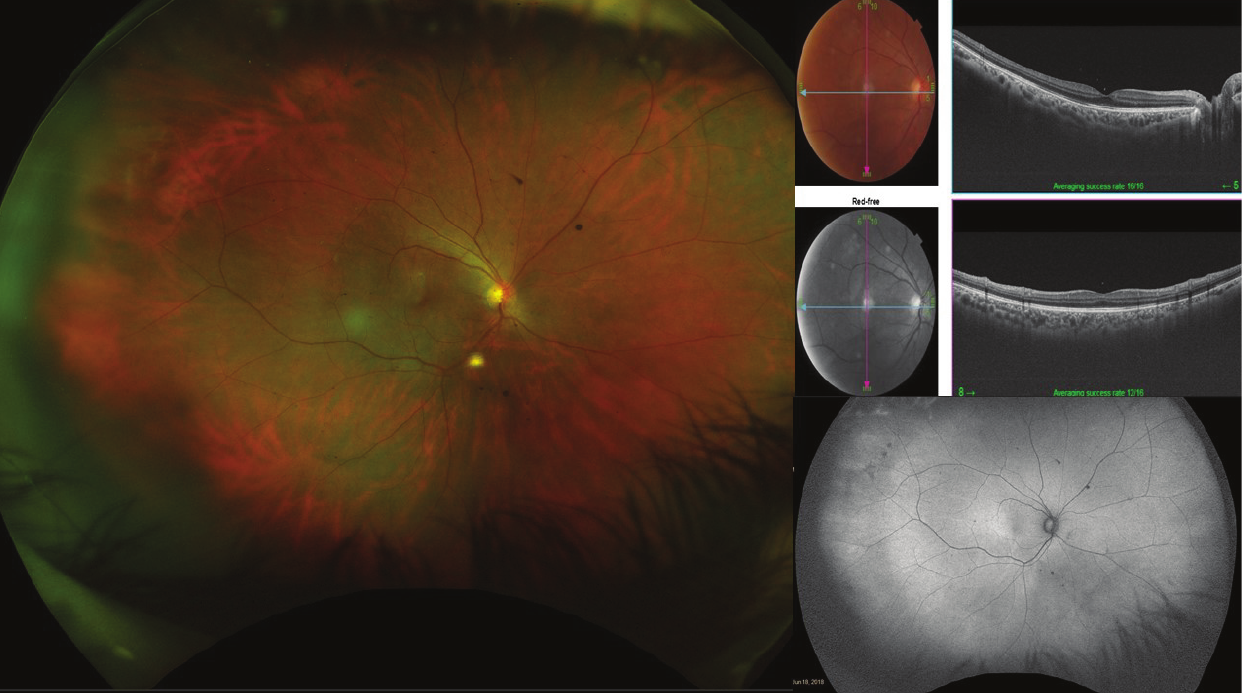
Figure 2. Fundus photo and OCT showing complete resolution of